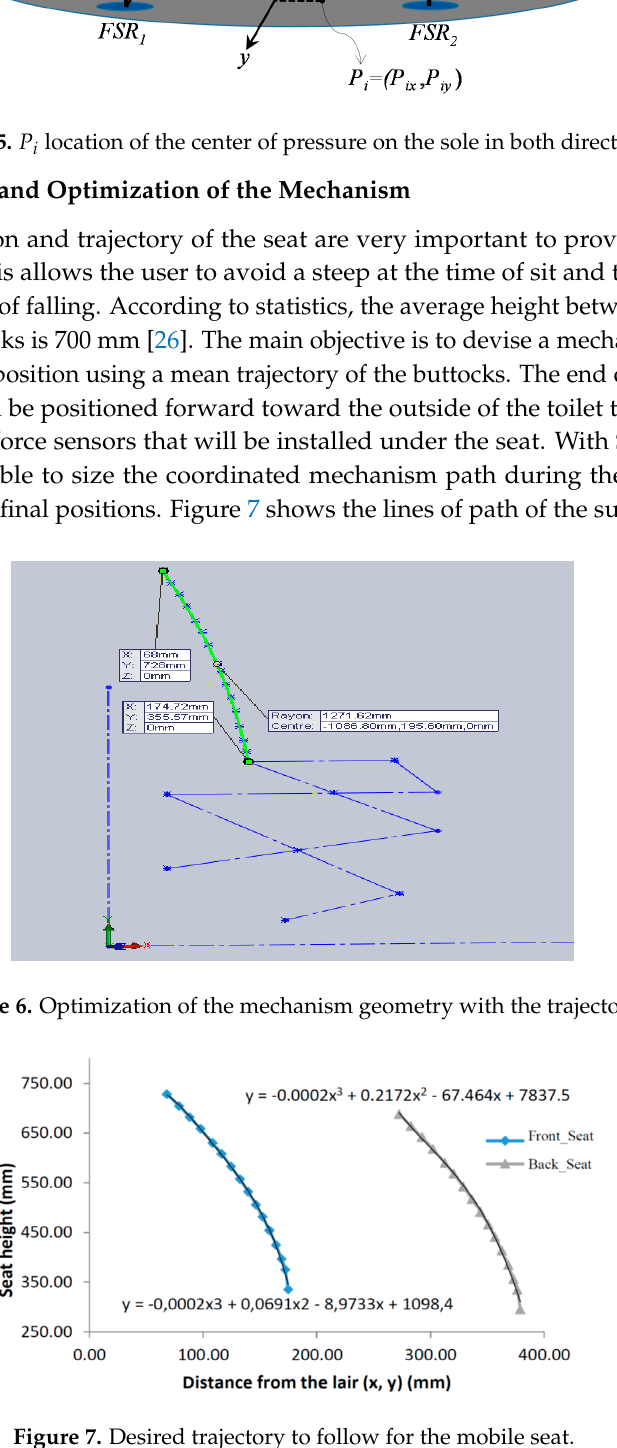
Figure 7. Desired trajectory to follow for the mobile seat.